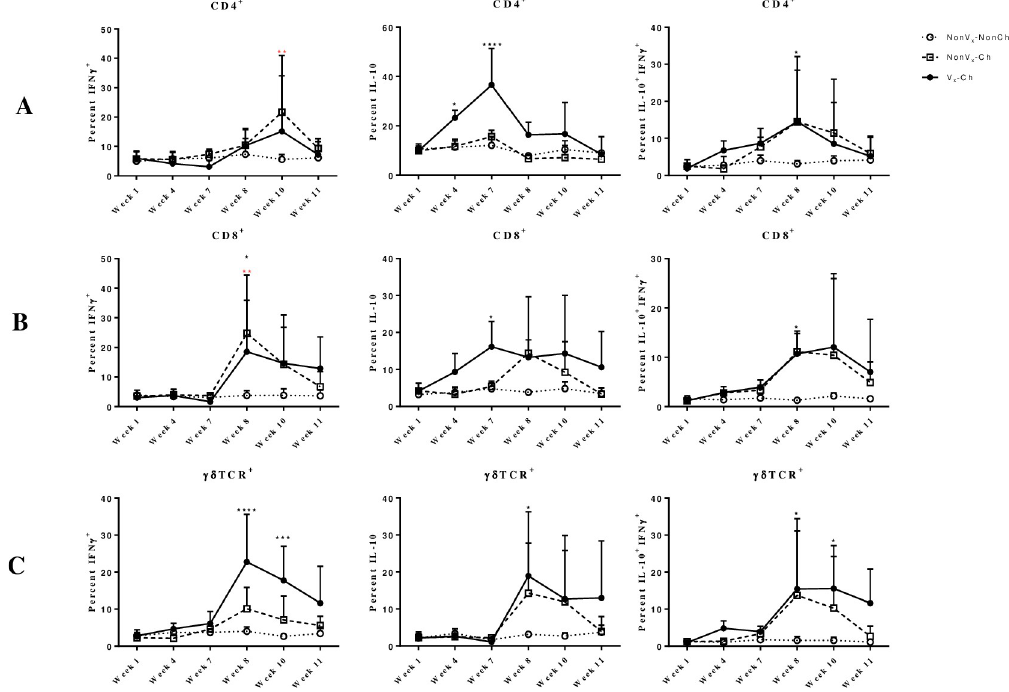
Fig 7. Percentage of IL-10 producing cells was greater than IFN- γ producing cells in vaccinated and challenged animals. Peripheral T cells were assessed for intracellular IFN- γ and IL-10 after 3-day stimulation of PBMC with E . coli O157:H7 antigen ex vivo . Panel A represents CD4 + lymphocytes; Panel B represents CD8 + lymphocytes, and Panel C represents γδ TCR + lymphocytes. Graphs in the left, middle, and right panels represent cells positive for intracellular IFN- γ , intracellular IL-10, or both intracellular IFN- γ and IL-10, respectively. Treatment groups are shown as open circles (NonVx-NonCh), boxes (NonVx-Ch), and filled circles (Vx-Ch). Black and red statistical symbols (asterisks) are comparisons between Vx-Ch and NonVx-NonCh groups, and NonVx-Ch and NonVx-NonCh groups, respectively. Bars represent Mean ± SD. n = 4 for NonVx-NonCh and NonVx-Ch and n = 8 for Vx-Ch. Statistical analysis was performed utilizing two way-ANOVA with parameters for time and experimental group with multiple comparison of